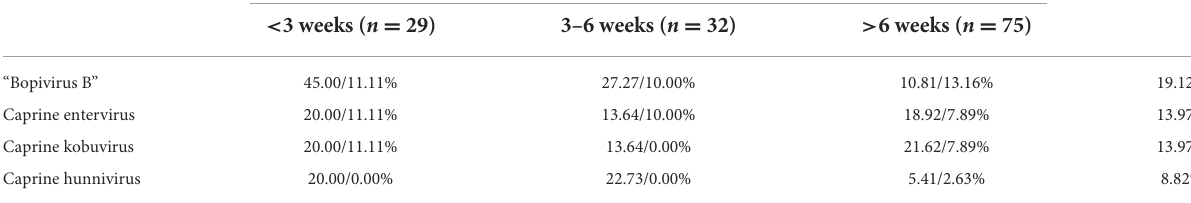
TABLE 3 Infection of “Bopivirus B” and other enteric viruses in goats of different